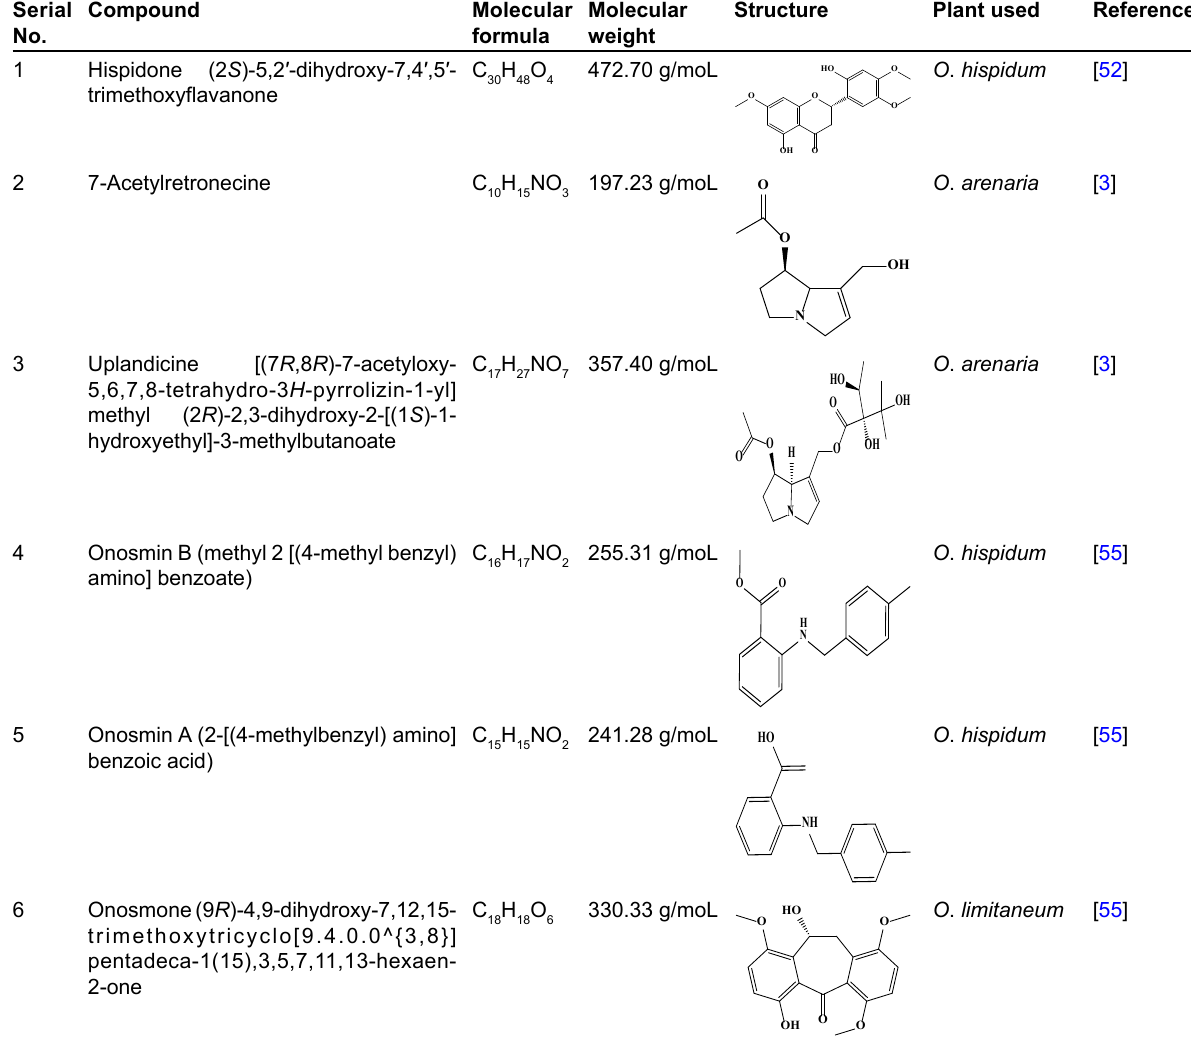
Figure 1. Different phytoconstituents present in the genus O . Table 1. Phytoconstituents procured from genus O